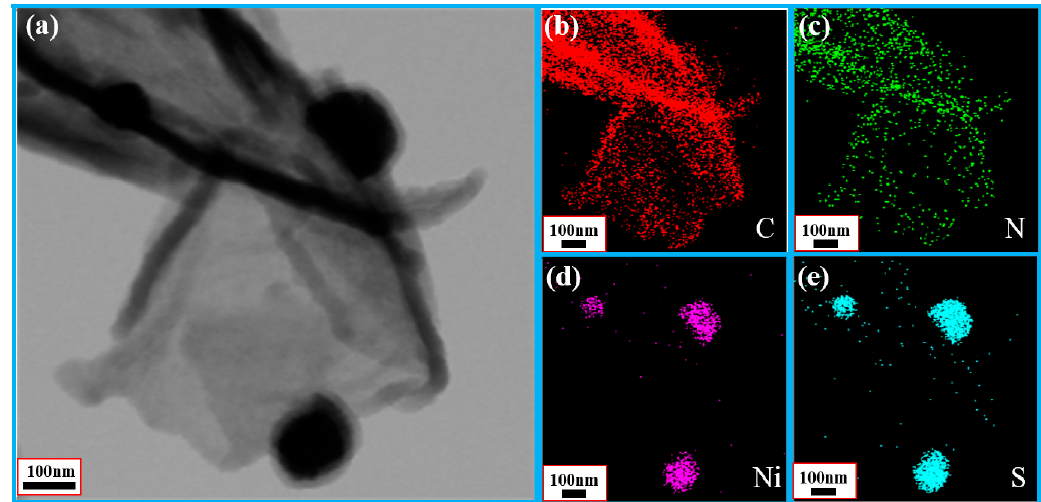
Figure 4. TEM image ( a ) and energy-dispersive X-ray spectroscopy (EDS) mapping images ( b – e ) of the NiS 2 @rGO/PPy ternary composite.